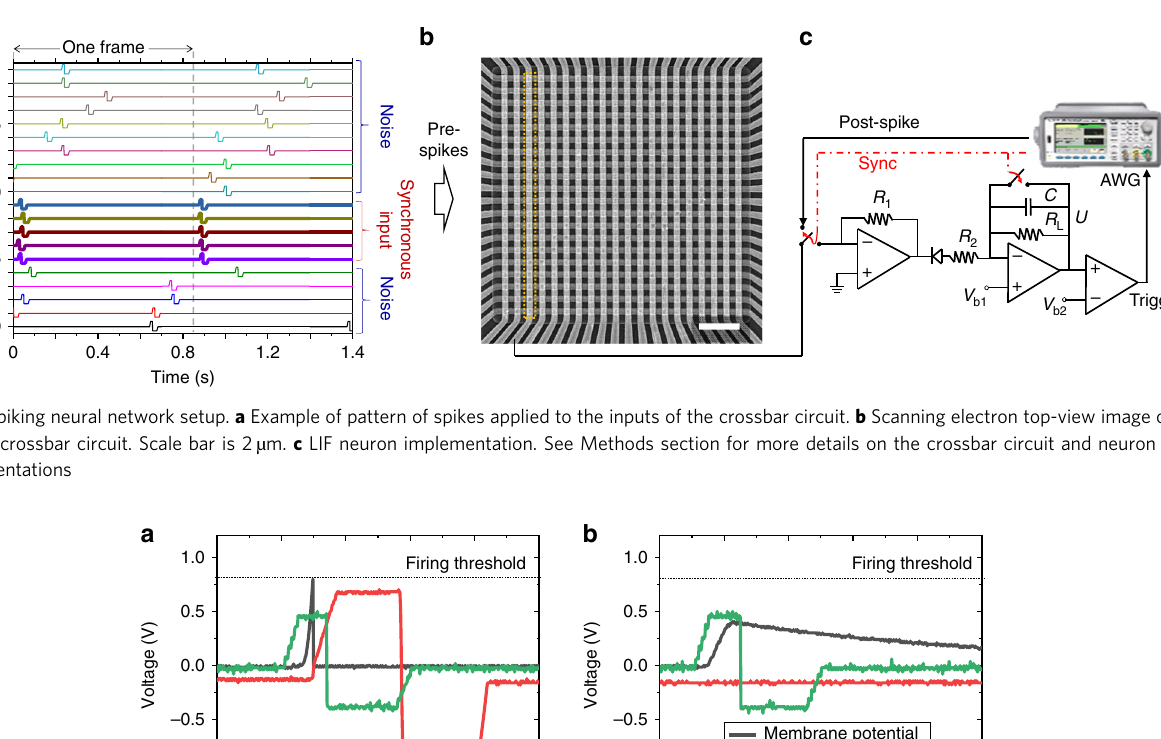
uncorrelated inputs. (One epoch is de fi ned as an application of ten frames. In each frame the spikes have the same reference positions with different random jitter and offsets.) Speci fi cally, for all these experiments, p spike = 1 so that the average spiking activity for all inputs was 1.19 Hz. To investigate the impact of